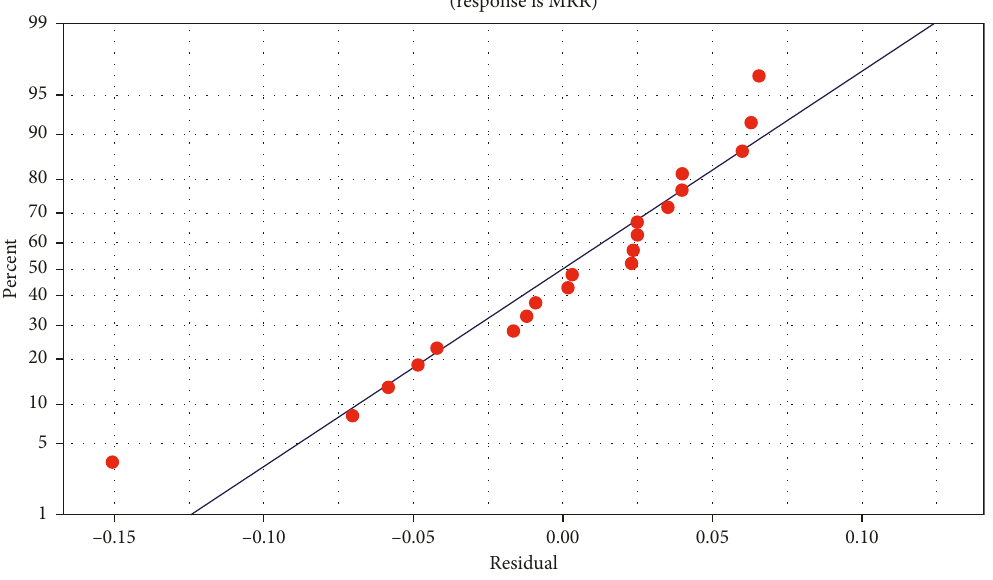
Figure 4: Normal probability plot of the residuals of the MRR.